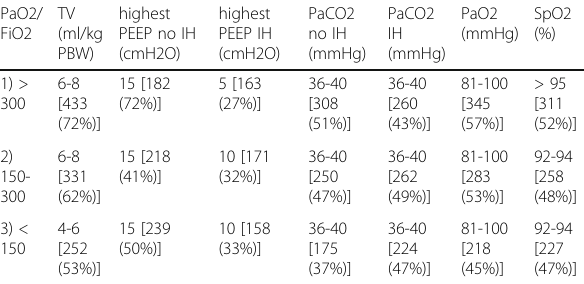
Table 1 (abstract 000188). Ventilator settings and respiratory targets in severe TBI patients according to acute lung injury